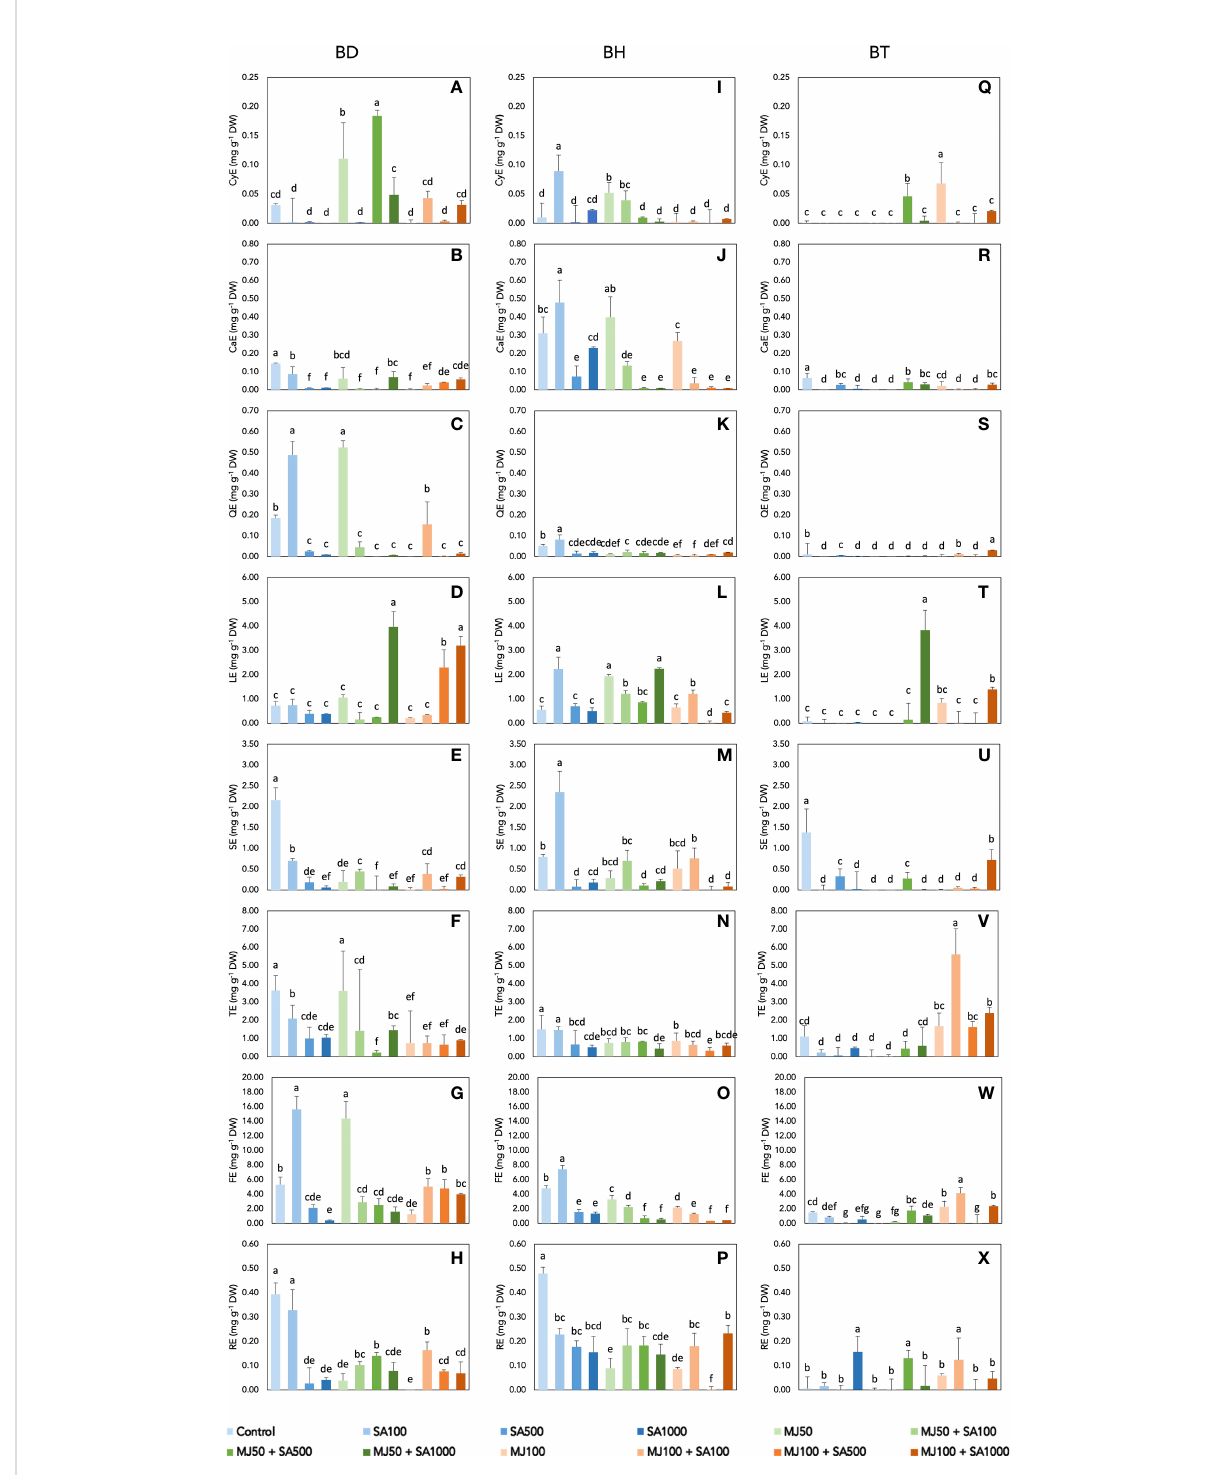
FIGURE 2 Semiquanti fi cation of phenolic compounds of elicited Bryophyllum PCSCs: (A – H) BD, (I – P) BH, and (Q – X) BT. The content of all phenolic subclasses was expressed in mg g -1 of dry weight (DW) as equivalents of a single representative standard: cyanidin equivalents (CyE) for anthocyanins; catechin equivalents (CaE) for fl avanols; quercetin equivalents (QE) for fl avonols; luteolin equivalents (LE) for fl avones and related compounds; sesamin equivalents (SE) for lignans; tyrosol equivalents (TE) for LMW phenolics; ferulic acid equivalents (FE) for phenolic acids; and trans- resveratrol equivalents (RE) for stilbenes. Vertical bars indicate standard deviation. MJ, methyl jasmonate; SA, salicylic acid. Different letters indicate signi fi cant differences between elicitor treatments according to Duncan ’ s post hoc test ( p<